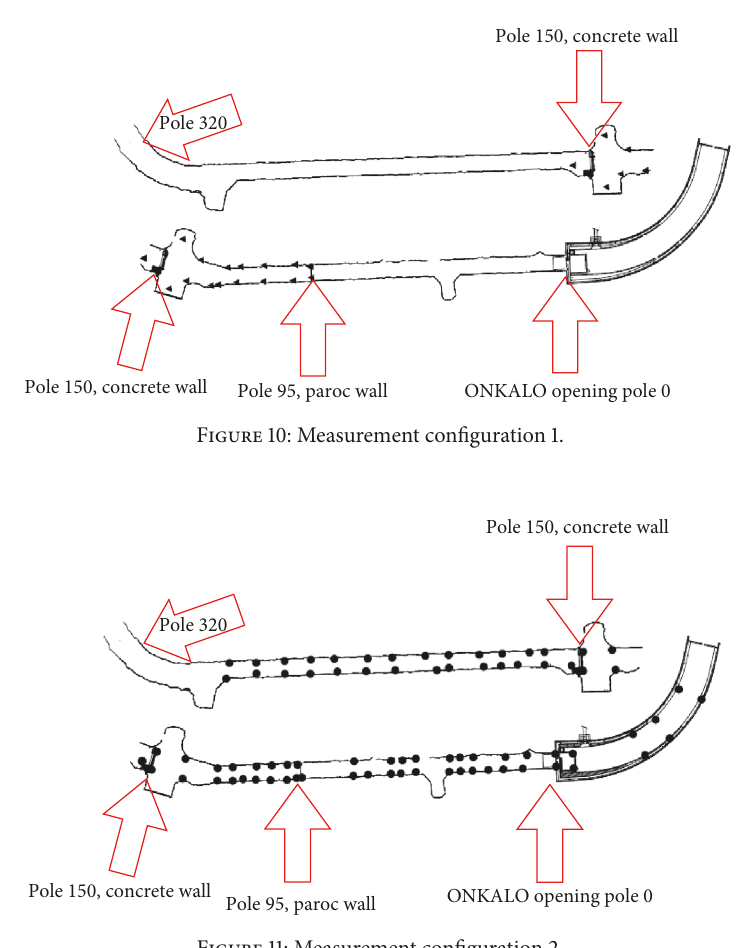
Figure 11: Measurement configuration